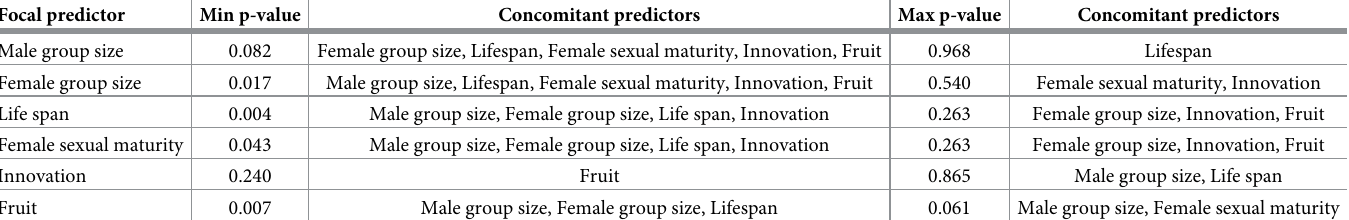
Table 5. Changes in p-value for each predictor when altering concomitant predictors using total brain as dependent variable. Read as follows: the focal predictor in the first column was estimated to a lowest p-value (out of all the 32 models the focal predictor where included in) shown in the second column when using concomitant predictors shown in column three. Likewise, the maximum p-value shown in column four, were estimated using concomitant predictors in column five. N = 40.